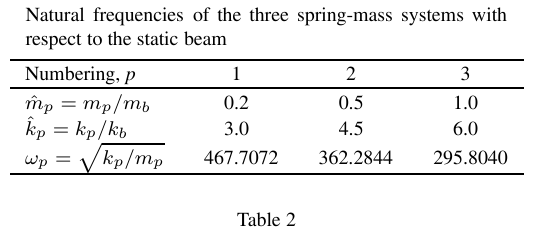
Table 1 Natural frequencies of the three spring-mass systems with